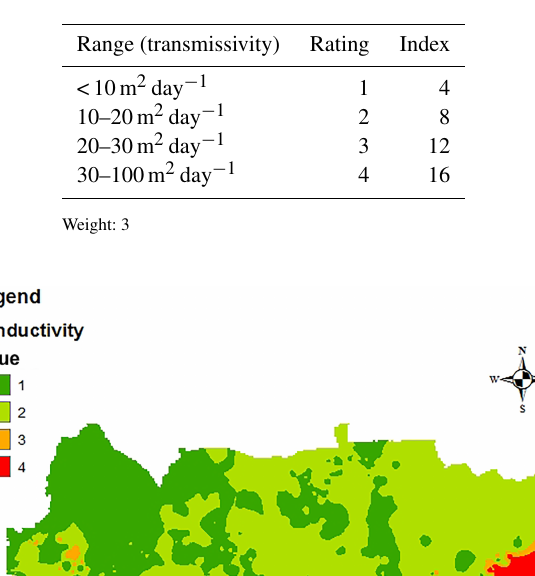
Table 6. Range and rating for vadose zone.